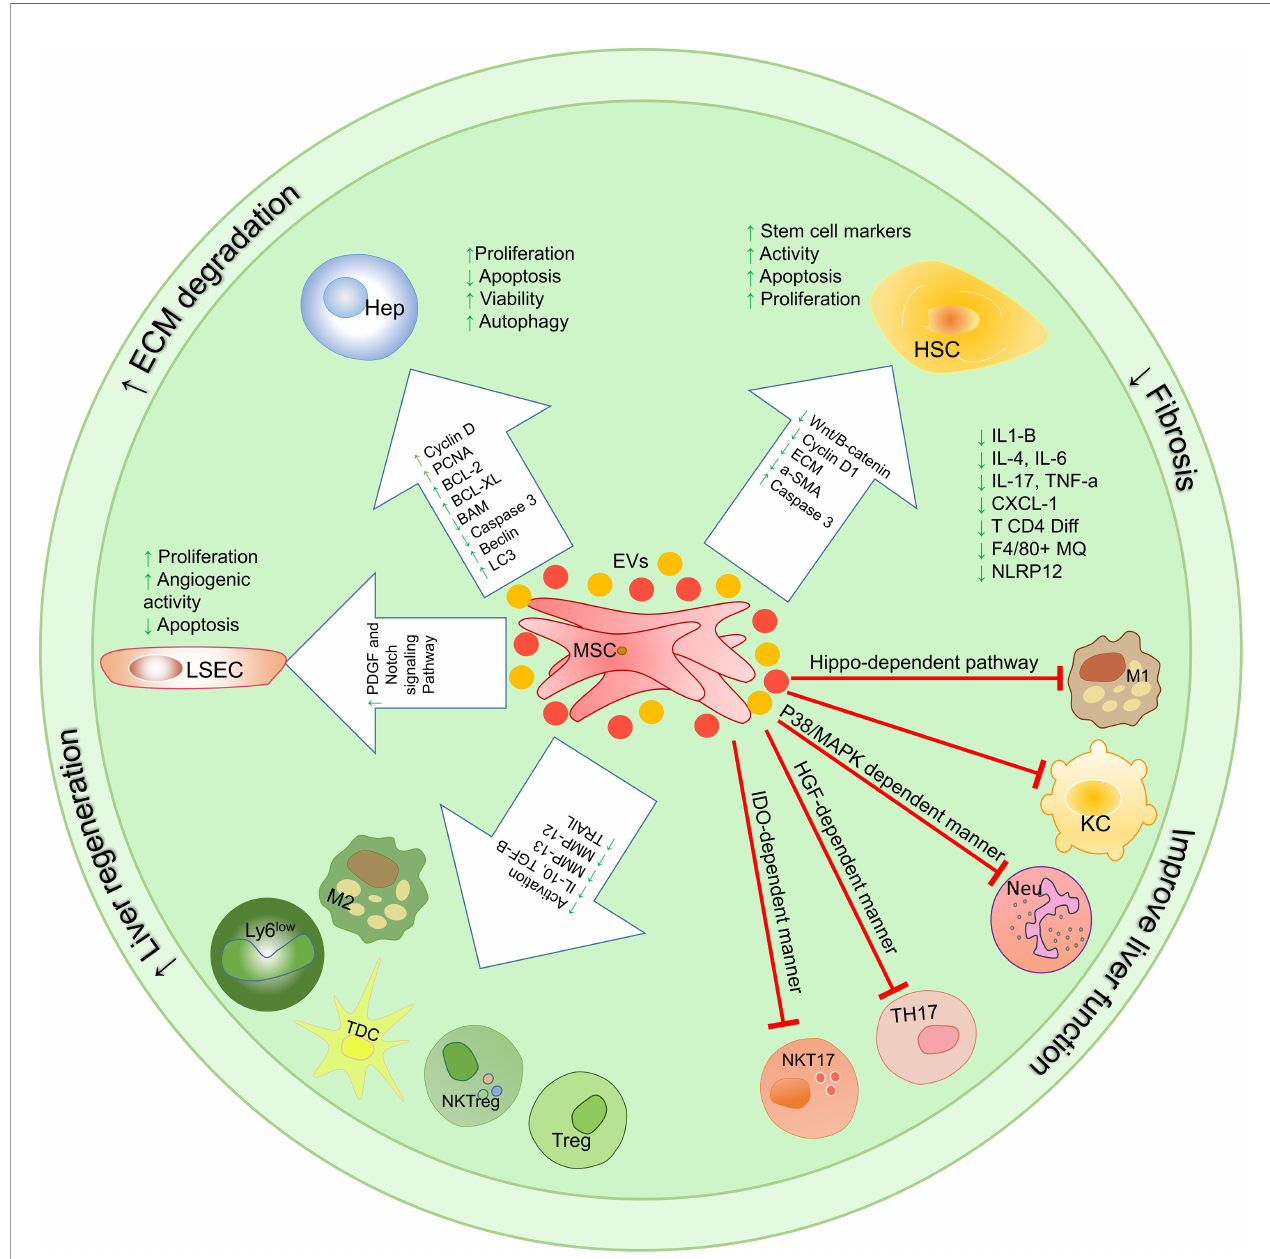
FIGURE 4 | Therapeutic mechanisms involved in using mesenchymal stem cells and their extracellular vesicles on the function of liver cells and immune system cells. MSC-EVs exert their therapeutic functions through 3 mechanisms that have been studied in vitro , pre-clinical, and clinical trials. These mechanisms include (1) proliferation induction/apoptosis suppression, (2) modulation of immune system responses, (3) reduction of fi brosis; HSCs, hepatic stellate cells; KCs, Kupffer cells; LSECs, hepatic sinusoidal endothelial cells; HEPs, Hepatocytes; TolDCs, Tolerogenic dendritic cells; cDC, Classic dendritic cells; ECM, extracellular matrix; MSCs, Mesenchymal stromal/stem cells;, M1 Macrophage type 1; M2, Macrophage type 2; MMPs, Matrix metalloproteinase; EVs, Extracellular